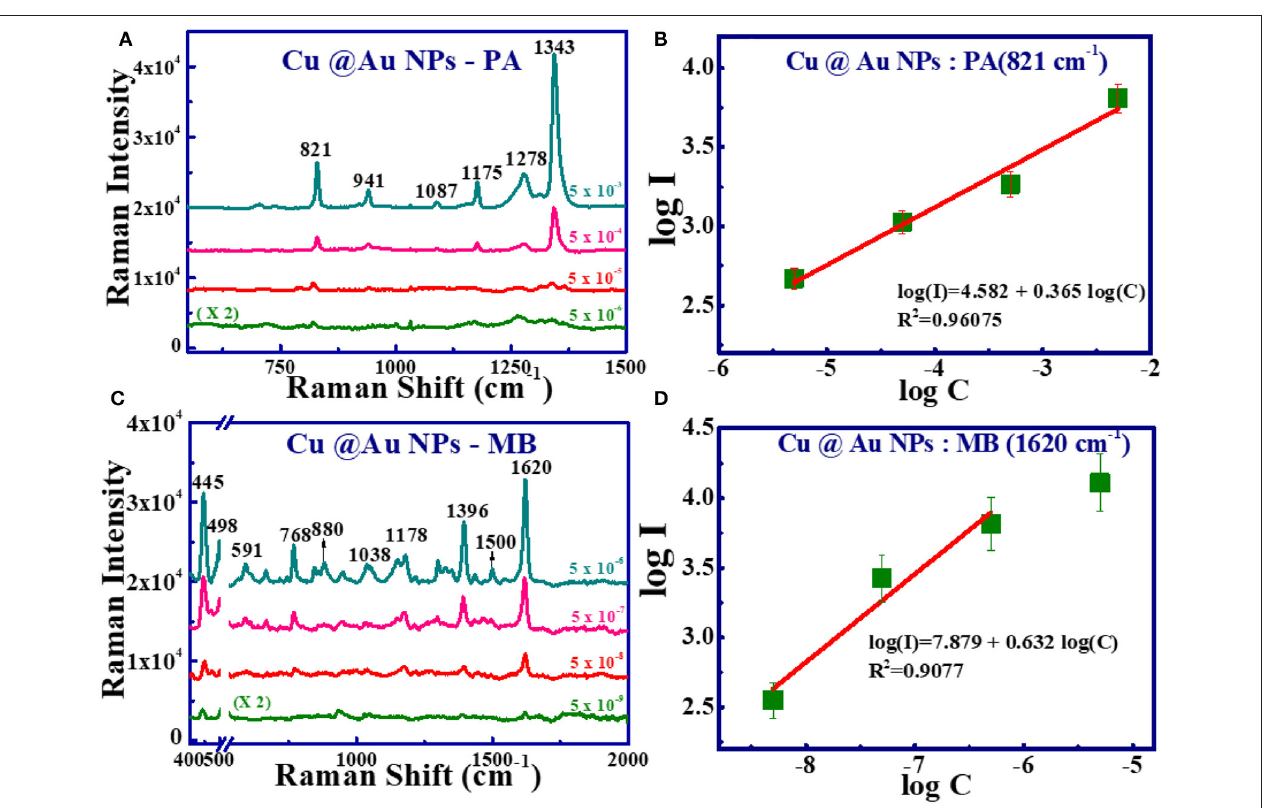
FIGURE 10 | Concentration-dependent SERS spectra of PA and MB recorded using Cu@Au NPs. (A) PA with concentration from 5mM to 5 µ M. (B) SERS intensity at 1,343 cm − 1 vs. PA concentration. (C) MB spectra from 5 µ M to 5nM. (D) SERS intensity at 1,622 cm − 1 vs. MB concentration with excitation at 785nm (Solid/green squares represents the experimental data and solid red line represents the theoretical fit). In (c) X-axis break has been used to avoid the strong Si peak at 520 cm − 1